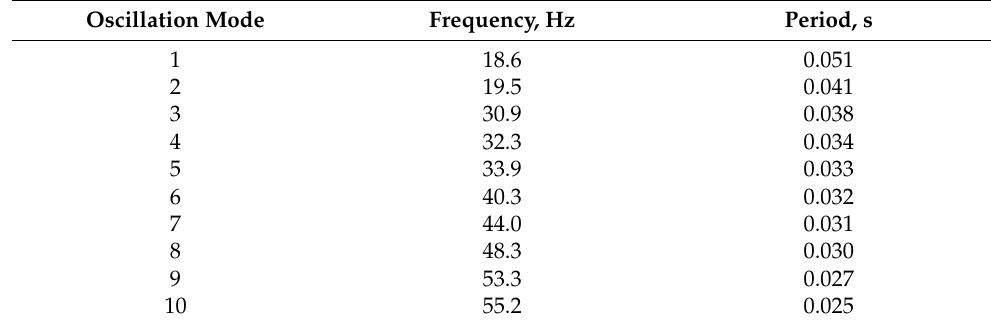
Table 1. Natural oscillation frequencies in carrying structure of the open